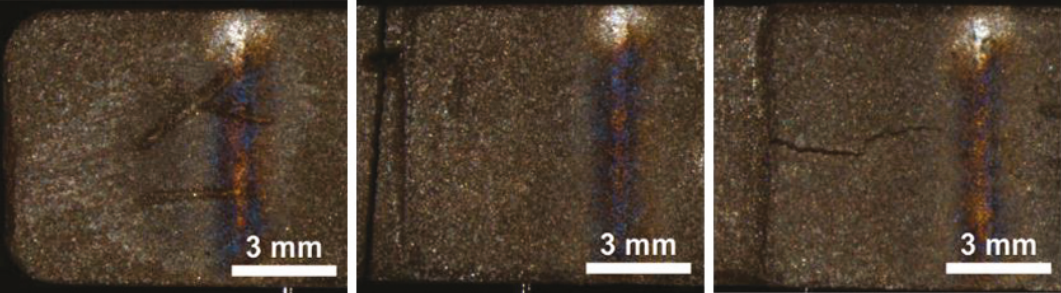
Figure 12: Optical micrograph of line sintering at di ff erent step heights. Left to right: 2, 4, and 6mm step